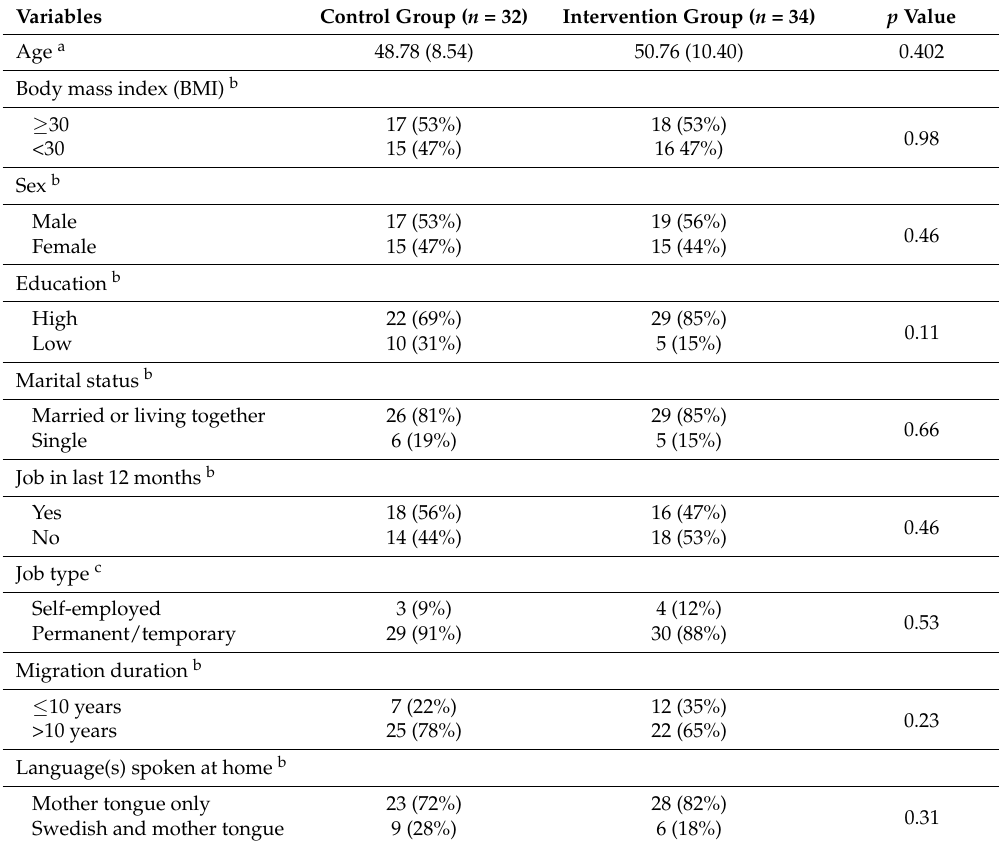
Table 1. Baseline characteristics of the Impact of Migration and Ethnicity on Diabetes in Malmö (MEDIM) participants answering the willingness-to-pay (WTP)